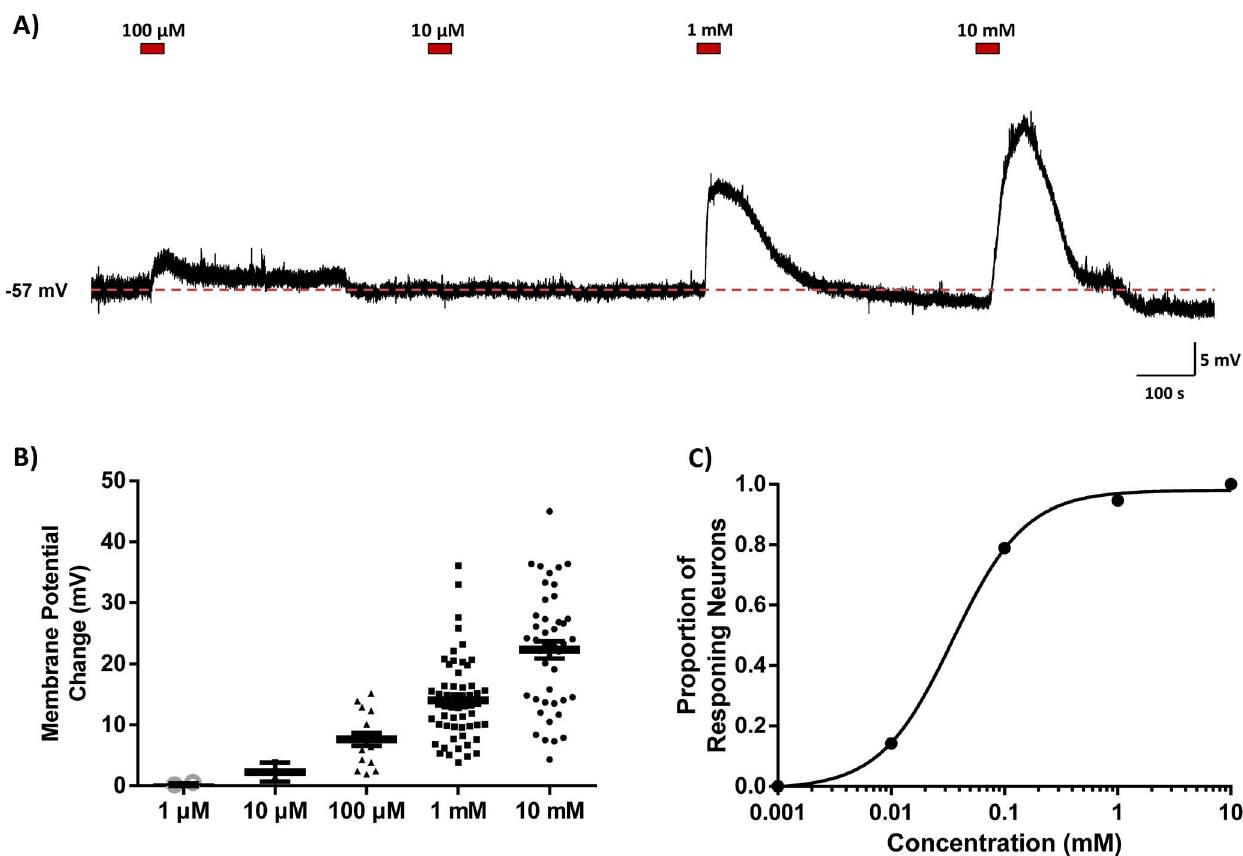
Figure 4. Hydrogen sulfide depolarizes neurons in a concentration-dependent manner. (A) Current clamp recording illustrating the concentration dependent effects of 4 different concentrations of NaHS (red bars indicate time of application) in a single SFO neuron. (B) Scatter plot indicating the membrane potential changes for all neurons recorded. Black bars indicate mean 6 SEM. (C) NaHS concentration curve illustrating proportion of responding neurons at each concentration, EC 50 =35.6 m M.